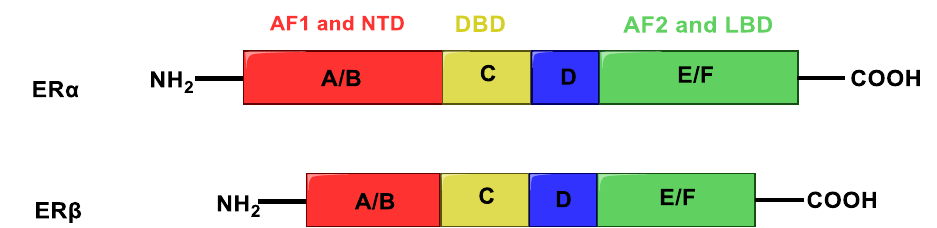
Figure 2. Structure of estrogen receptors. A/B (red) indicates the activation function 1 (AF1) and the N-terminus domain (NTD), C (yellow) the DNA binding domain (DBD), D (blue) the hinge region, E/F (green) the activation function 2 (AF2) and ligand-binding domain (LBD).